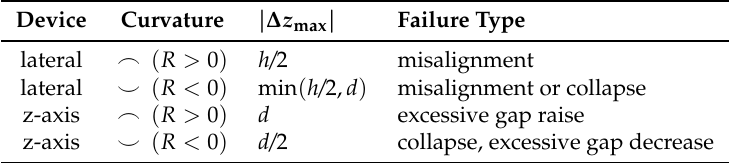
Table 6. Pass/fail criteria to estimate the maximum MEMS dimensions for a given curvature type and